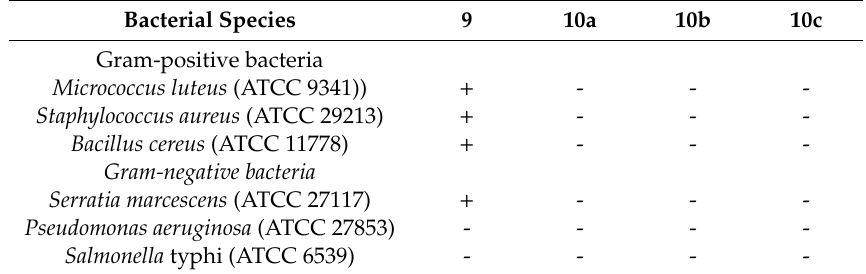
Table 1. Antimicrobial activity of compounds 9 , 10a , 10b , 10c against di ff erent Gram-positive and Gram-negative